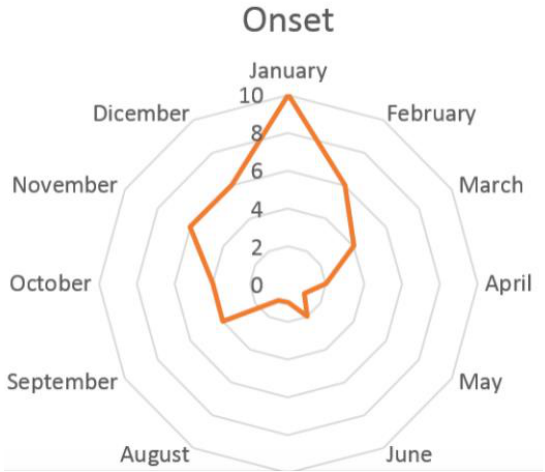
Figure 2. Distribution of the onset of NDPH during the year.